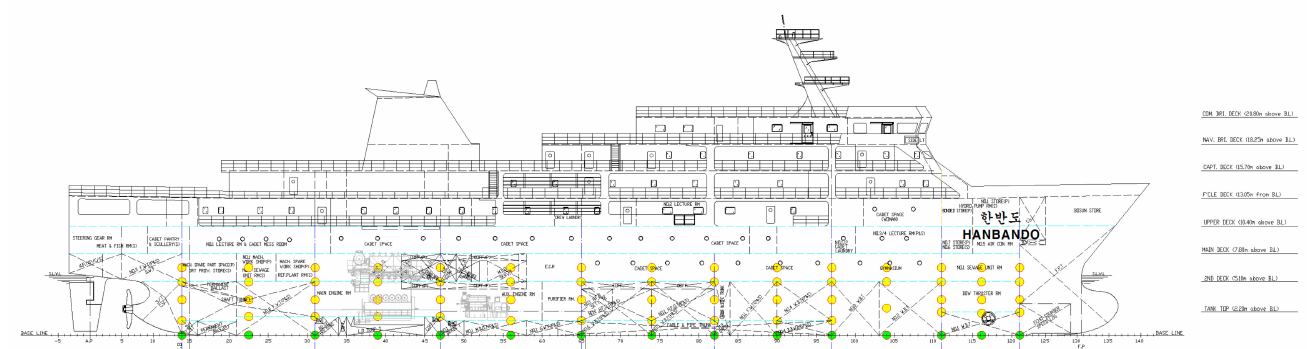
Figure 4. Simulated ship model profile and the locations of damage